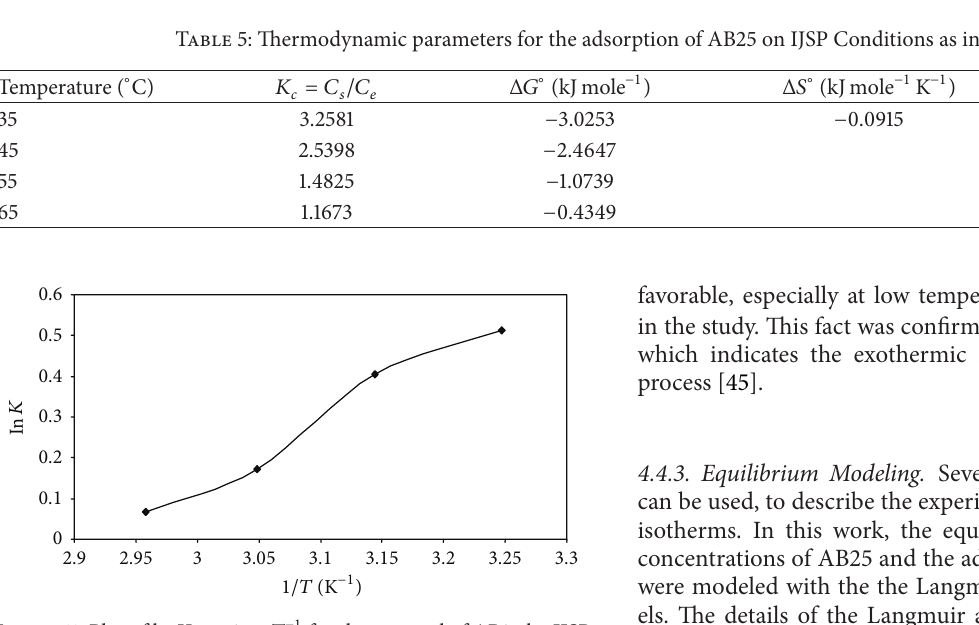
Figure 11: Plot of ln 𝐾 𝑐 against 𝑇 −1 for the removal of AB25 by IJSP. Conditions as in Figure